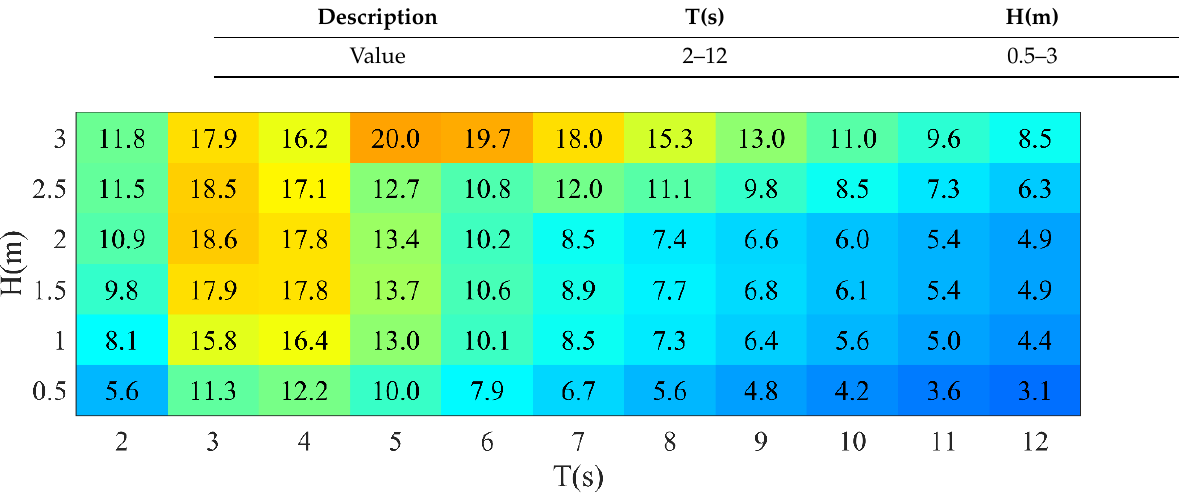
Table 3. Study of sea state.